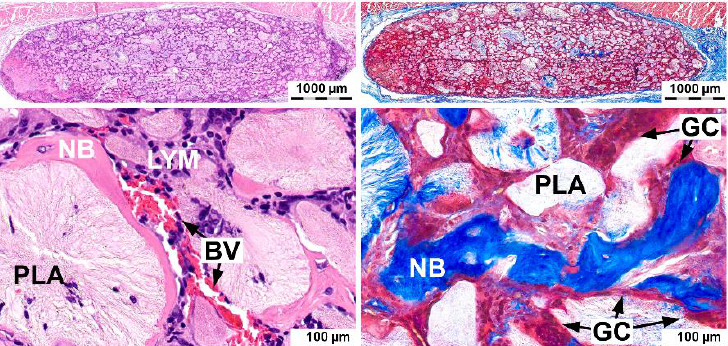
Figure 5. Bone formation after subcutaneous implantation of the composition containing 10 µg/mL of BMP-2. H&E and Masson’s trichrome staining after 28 days. PLA — highly porous polylactide granules, NB — newly formed bone, BV — blood vessel, GC — foreign-body giant cell, LYM — lymphocytes, and plasma cells.